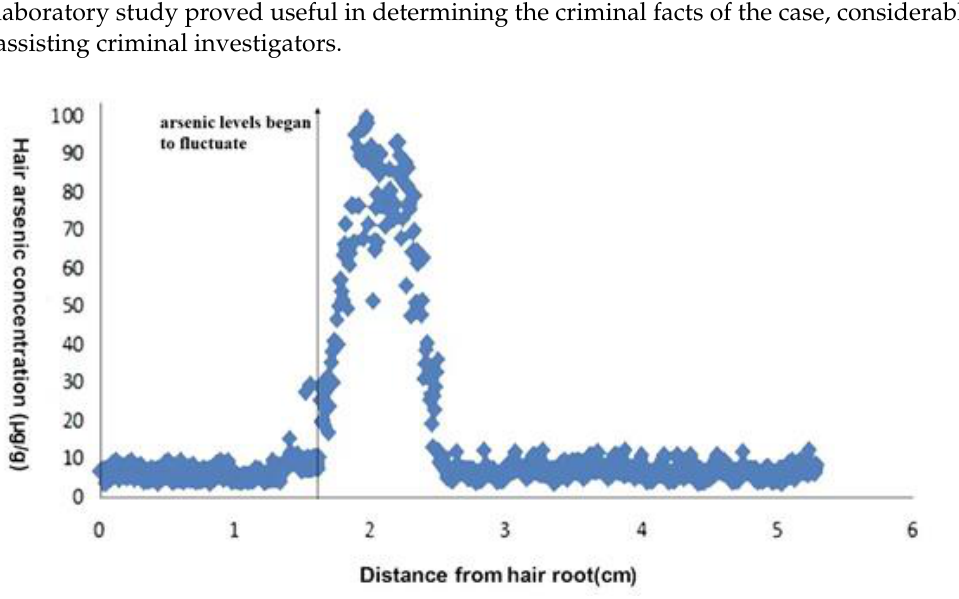
Figure 4. Concentration along hair from a victim of arsenic poisoning.